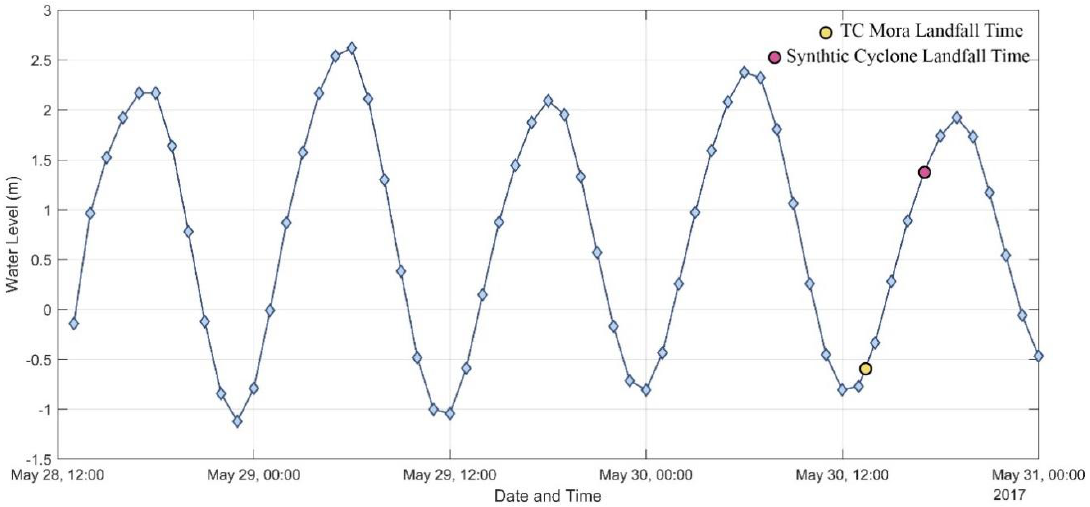
Figure 3. Landfall time of TC Mora and selected landfall time of the “synthetic cyclone”.